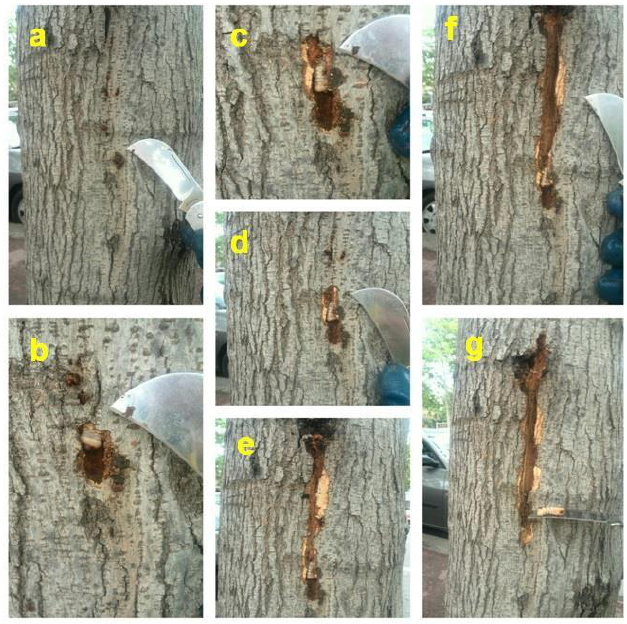
Figure 7. Same as in Figure 6. The sequential images here go from ( a – g ). (Photos Jordi Serra).